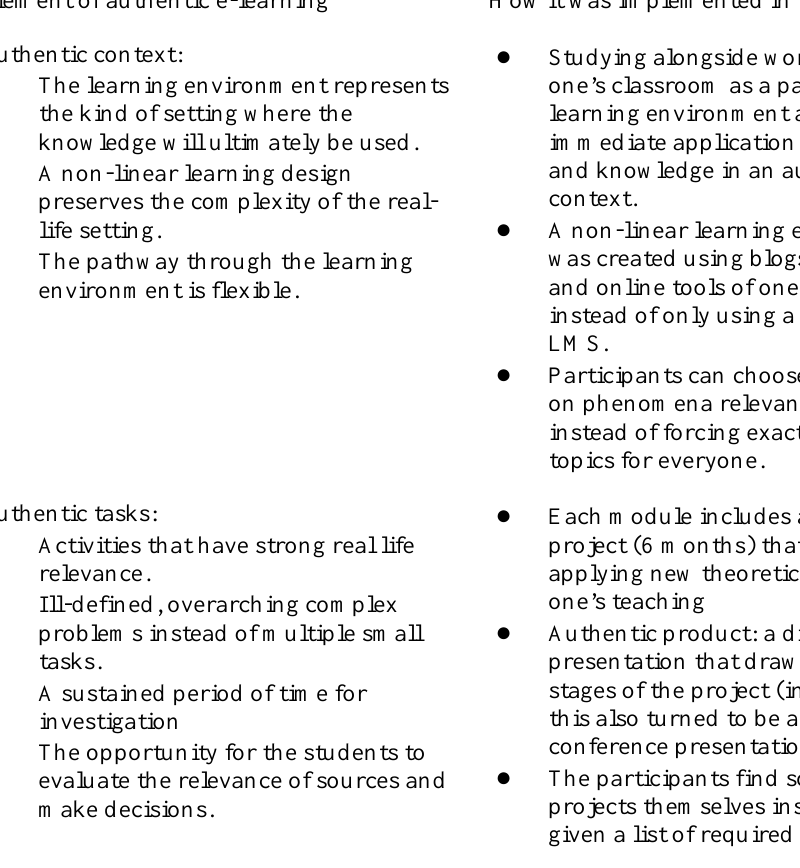
The Elements of Authentic e-Learning (Herrington et al., 2010) and their Application in the 21 st Century Educators